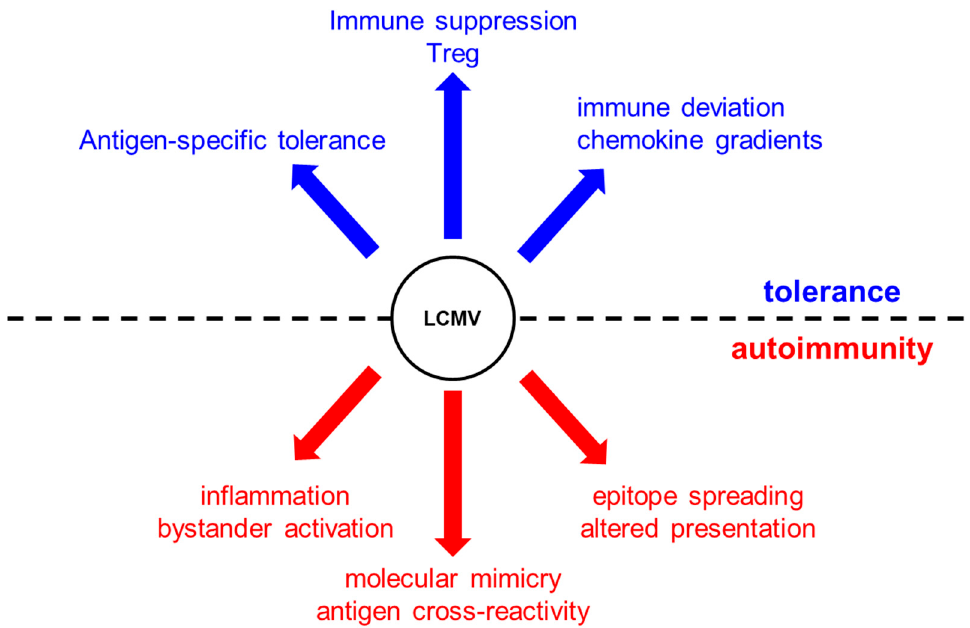
Figure 1. Lymphocytic choriomeningitis virus (LCMV) infection can induce tolerance and promote autoimmunity via mechanisms that include antigen-specific tolerance, immune suppression (death of autoreactive T cells) Treg invigoration, and immune deviation via chemokine gradients (e.g., CXCL10). In contrast, virus infection can initiate or propagate an autoimmune disease via epitope spreading and molecular mimicry, inflammation, and activation of antigen-presenting cells (APCs) that present self-antigens.